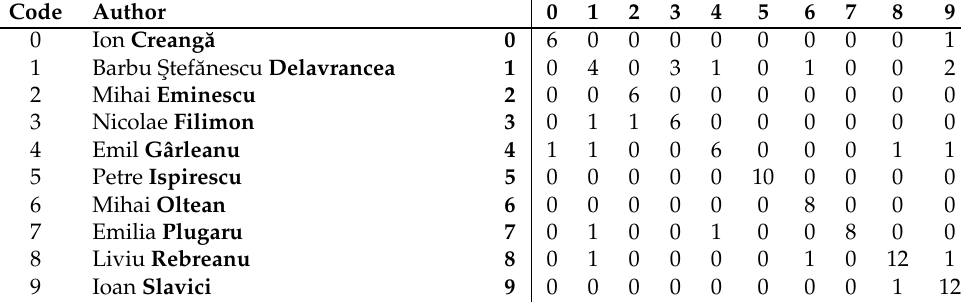
Table 19. Confusion Matrix (on the right side). Column headers and row headers (i.e., numbers from 0 to 9 that are written in bold) are the codes 1 given to our authors, as specified on the left side.